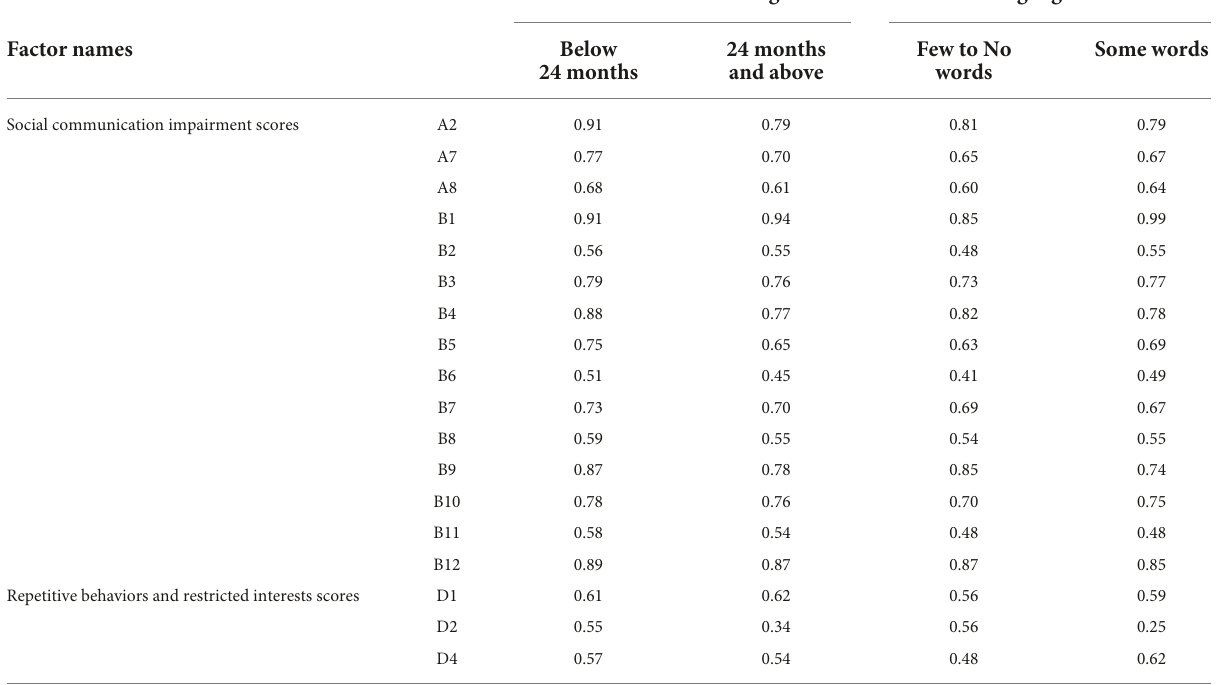
TABLE 4 Item factor loadings on the two factors from CFA across the